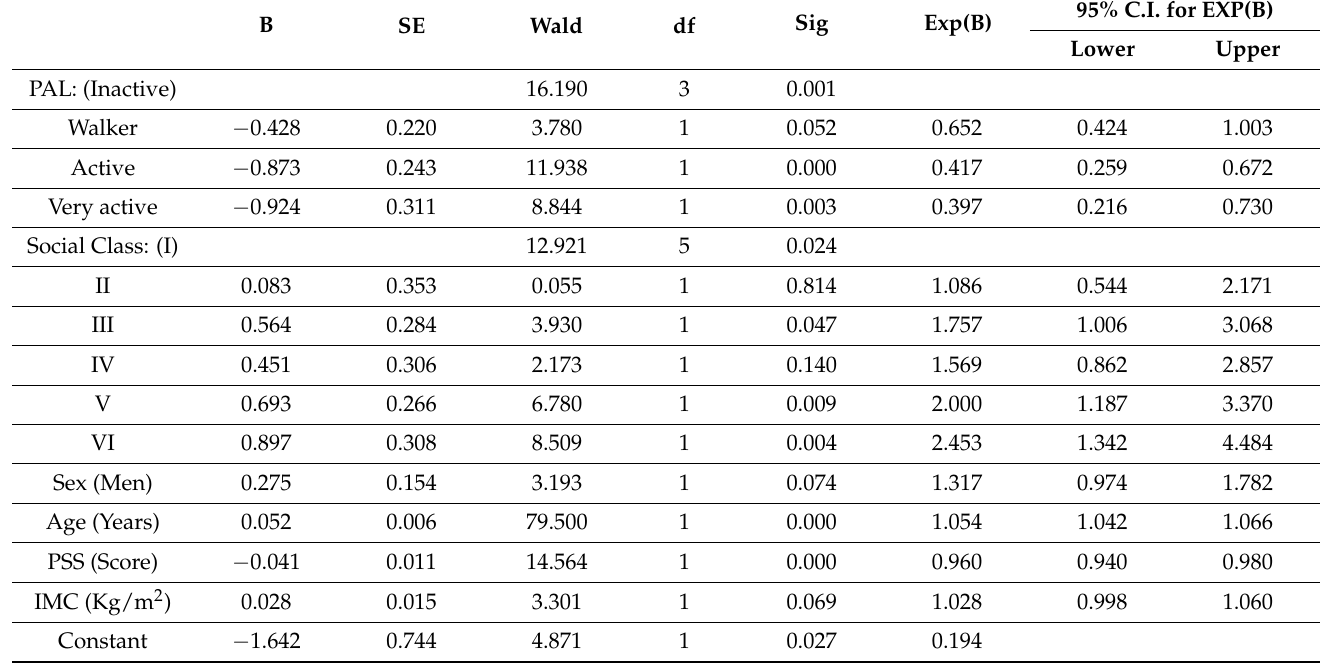
Table 5. Multiple binary logistic regression analysis for negative Self Perceived Health